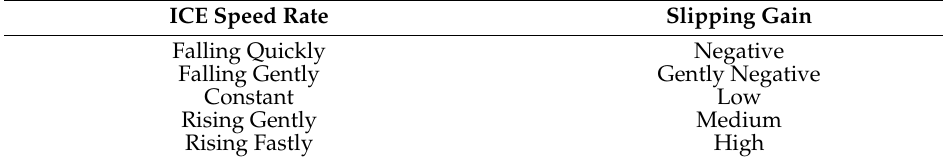
Table 2. ICE speed laws.